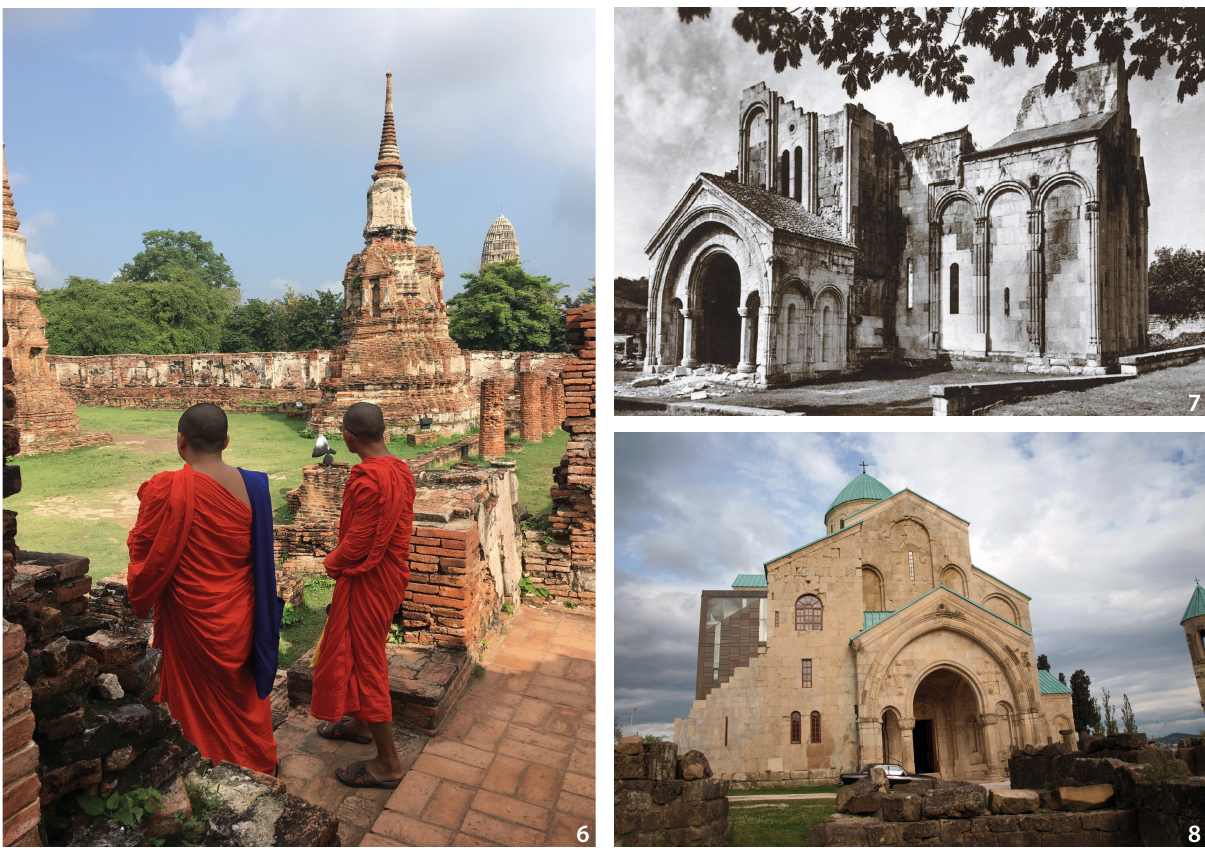
Figure 6 Ayutthaya (Source: the author). Figure 7 Bagrati Cathedral in ruined condition (Source: National Agency for Cultural Heritage Preservation of Georgia). Figure 8 Bagrati Cathedral after restoration (Source: Tamar Meliva